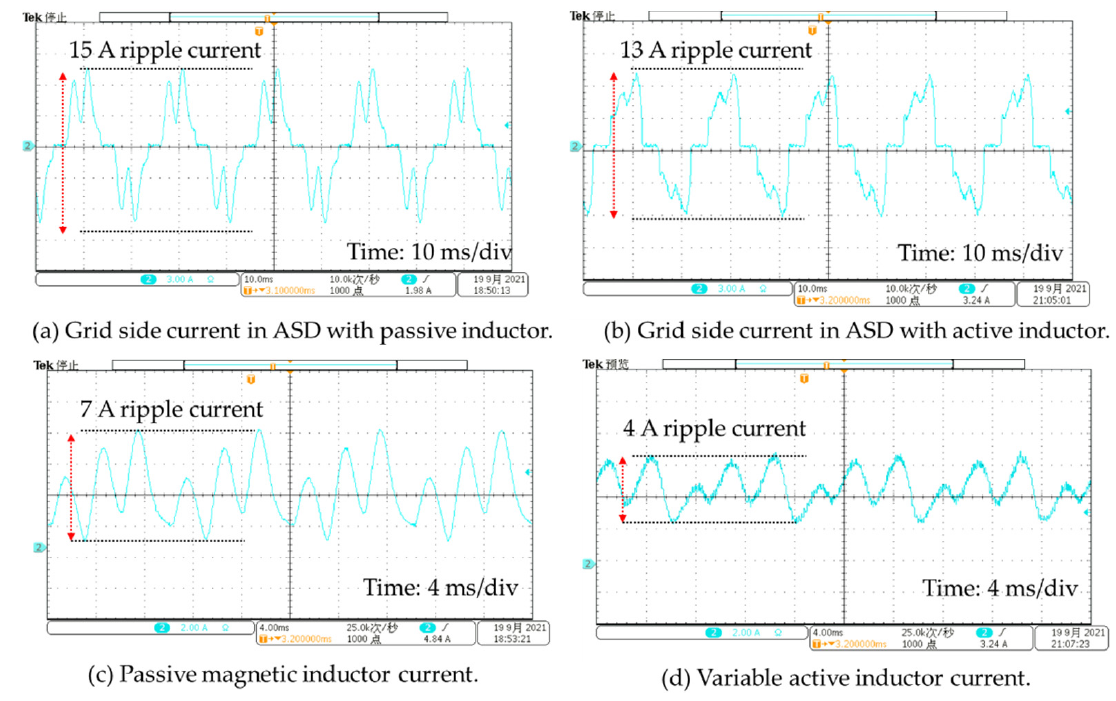
Figure 10. Test results of the passive magnetic inductor and variable active inductor under the unbalanced grid voltage condition in the ASD system. ( a ) Grid side current in ASD with passive inductor; ( b ) Grid side current in ASD with active inductor; ( c ) Passive magnetic inductor current; ( d ) Variable active inductor current.